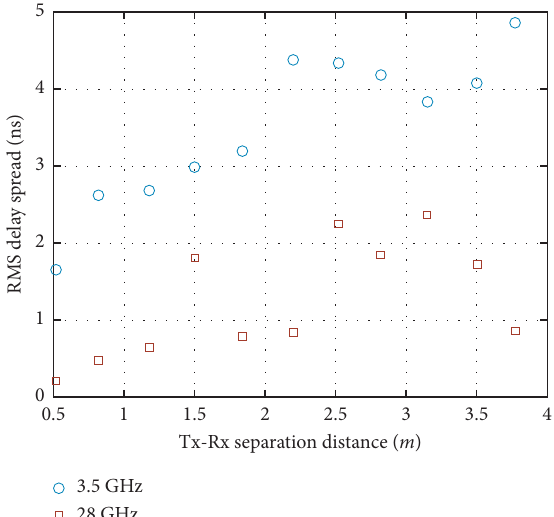
Figure 7: RMS delay spread at 3.5GHz and 28 GHz.